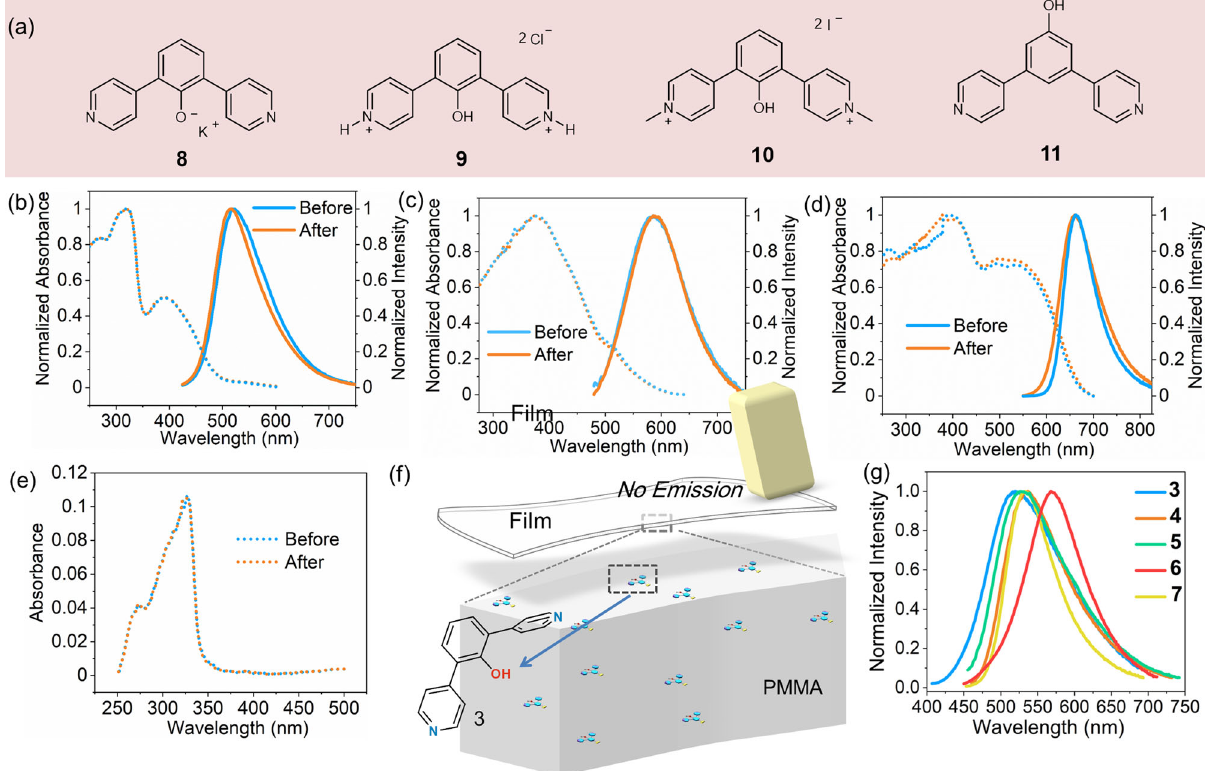
Fig. 4 Control study. a Chemical structure of reference compounds 8~11. Normalized absorption and emission spectra of b 8, c 9, d 10, and e absorption spectra of 11 in their solid-state form; f Silent rubbing-induced photoluminescence in the fi lm made from the mixture of compound 3 and PMMA; g normalized emission spectra of the rubbed solid samples of